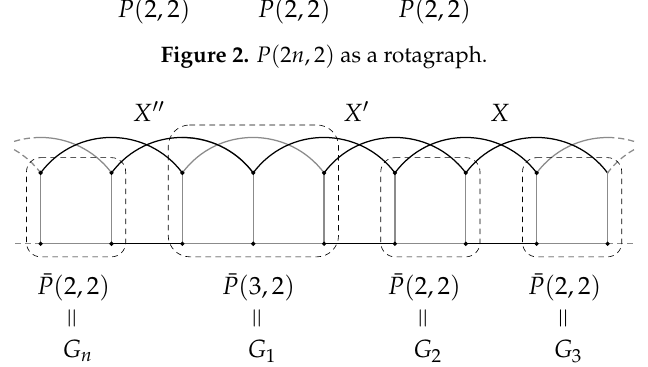
Figure 3. P ( 2 n + 1,2 ) as a nearly rotagraph.